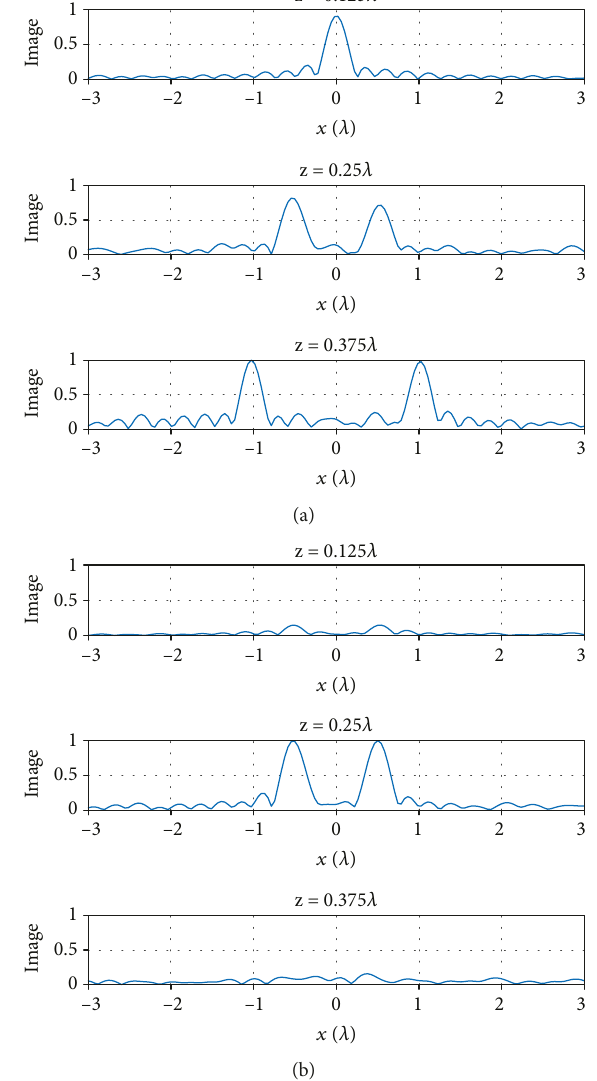
Figure 11: Reconstructed images when using 13 resonant dipole antennas. (a) For this example, the parameters are z = λ /8 1 (0.125 λ ), z = λ /4 (0.25 λ ), z =3 λ /8 (0.375 λ ), d = λ , d =2 λ , s = λ / 2 3 2 3 8, and D =0.25 λ . (b) Setup similar to the one presented in = λ /8 and Figure 11(a) but when removing the objects at z 1 z =3 λ /8 and shifting the objects at z = λ /4 toward the aperture 3 2 by λ /32. In this case, these two objects will have a distance of 3 λ / 32 from the fi rst imaged line and λ /32 from the second imaged line. These results are with SNR